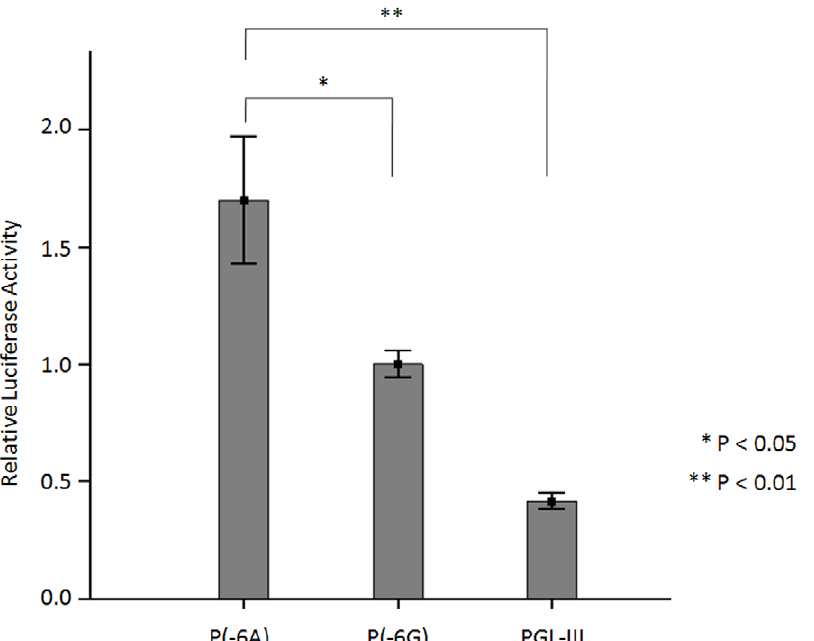
Figure 4. Comparison of the transcriptional activities of reporter constructs containing AGT proximal promoter polymorphisms in HepG2 cells. Transcriptional activities are presented as a ratio of the activity of the p(-6G) promoter-luciferase construct. pGL3 represents the blank vector, which does not contain any AGT promoter sequence. Values are presented as means 6 SE.